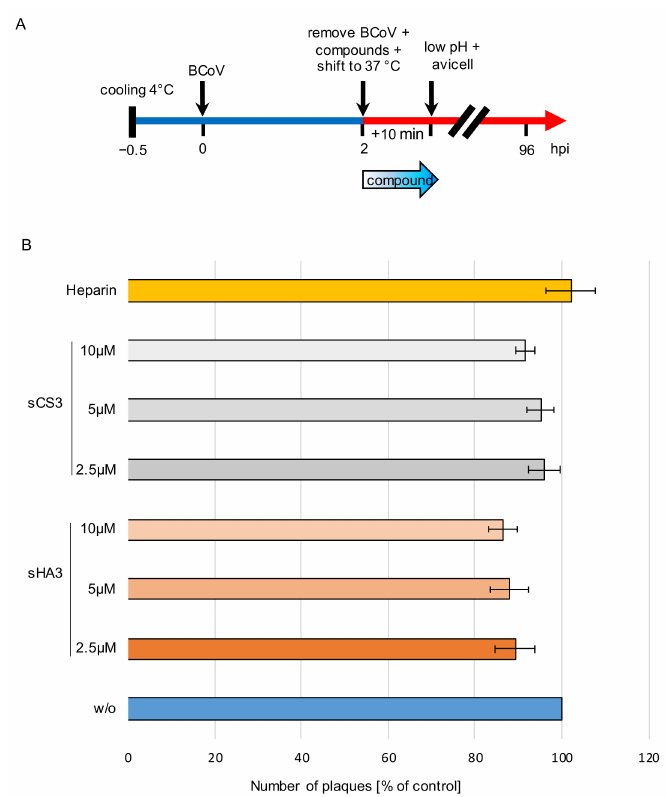
Figure 6. Effects of the high-sulfated GAGs on penetration. ( A ) Diagram of the experimental settings. ( B ) Prechilled PT cells were infected with prechilled BCoV (MOI 0.00005) for 2 h at 4 ◦ C. Thereafter the cells were treated with 2.5 µ M, 5 µ M or 10 µ M sHA3 or sCS3 or 10 µ g/mL heparin or left untreated ( w / o ). Penetration was allowed for 10 min at 37 ◦ C and stopped by low pH treatment (pH 3.0). Cells were overlaid with Avicel RC-581 and incubated for 4 days. Error bars on the histogram are SD from three independent